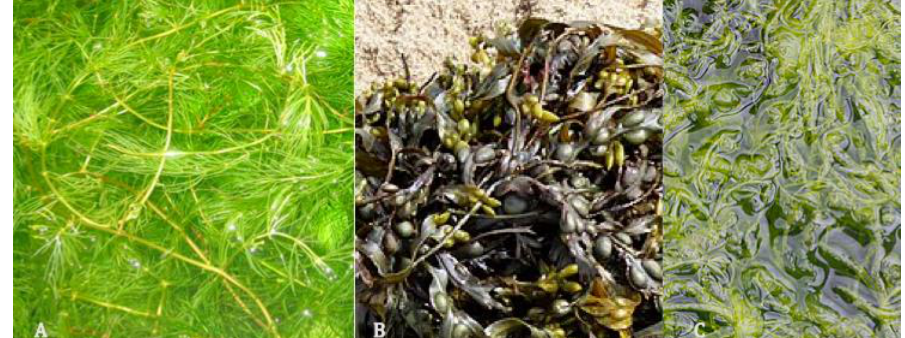
Fig. 1. Species selected for study: a) Cerathophyllum demersum ; b) Fucus vesiculosus ; c) Ulva intestinalis